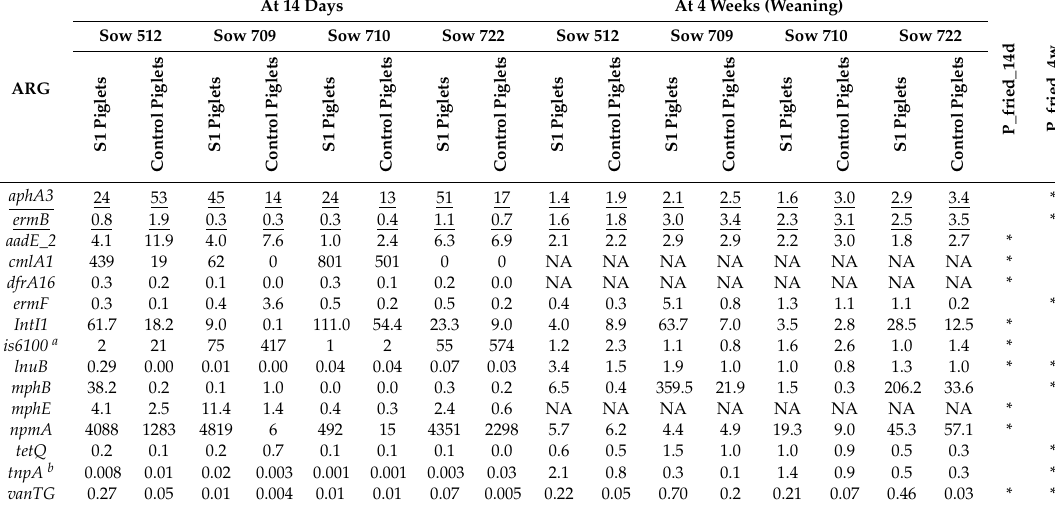
Table 1. Impact of the suspension from donor sow 268 (S1) on the abundance of antibiotic resistance genes (ARGs) and related genes in the piglets at 14 days and at 4 weeks (median values). The ARG abundances are normalized by the abundance of the 16S rRNA gene. The numbers are not between 0 and 1 because the ARGs were pre-amplified, whereas the 16S rRNA genes were not (see Materials and Methods section, Table S3 and Figure S5). The ARGs aphA3 and ermB are underlined because they are decreased by the inoculation of the microbial suspension S1.